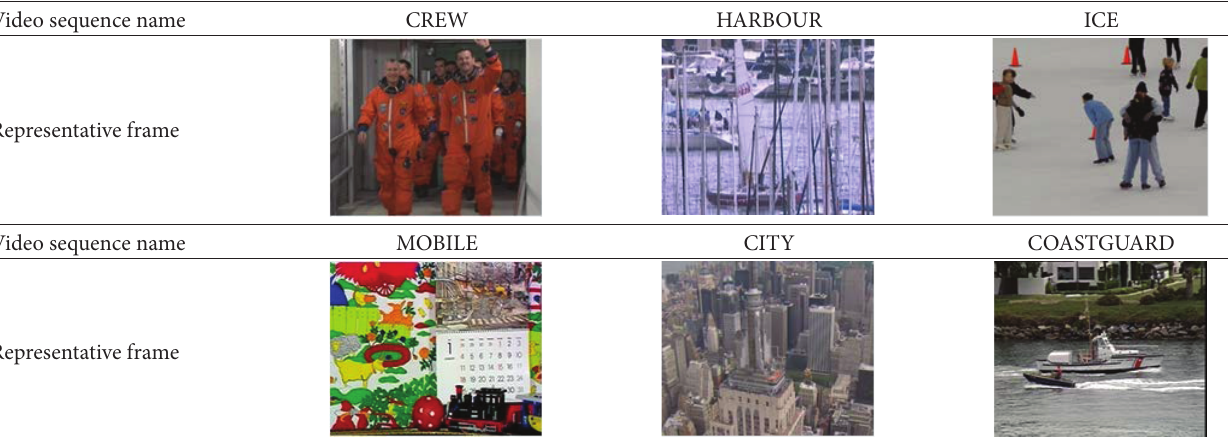
Table 3: Standard video sequences.